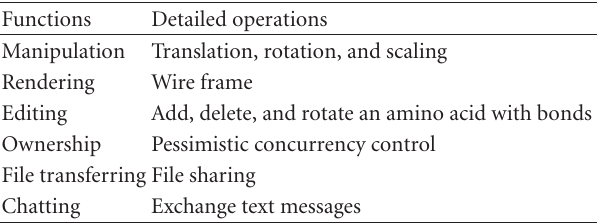
Table 2: Supporintg functions in